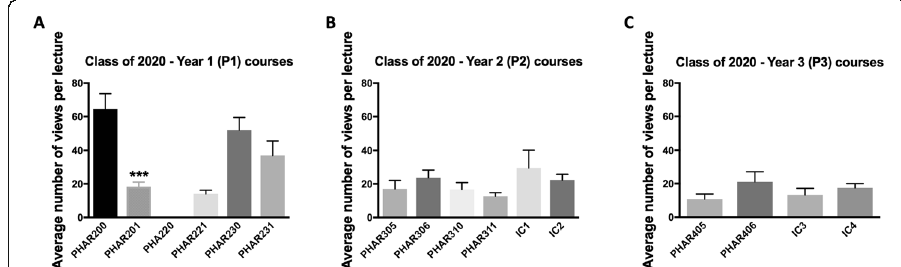
Fig. 4 Comparison of Fall and Spring semester courses over three academic years in Class of 2020. The bar charts represent the average number of views per lecture expressed as mean ± SEM. *** P < 0.001 versus PHAR200 (panel a